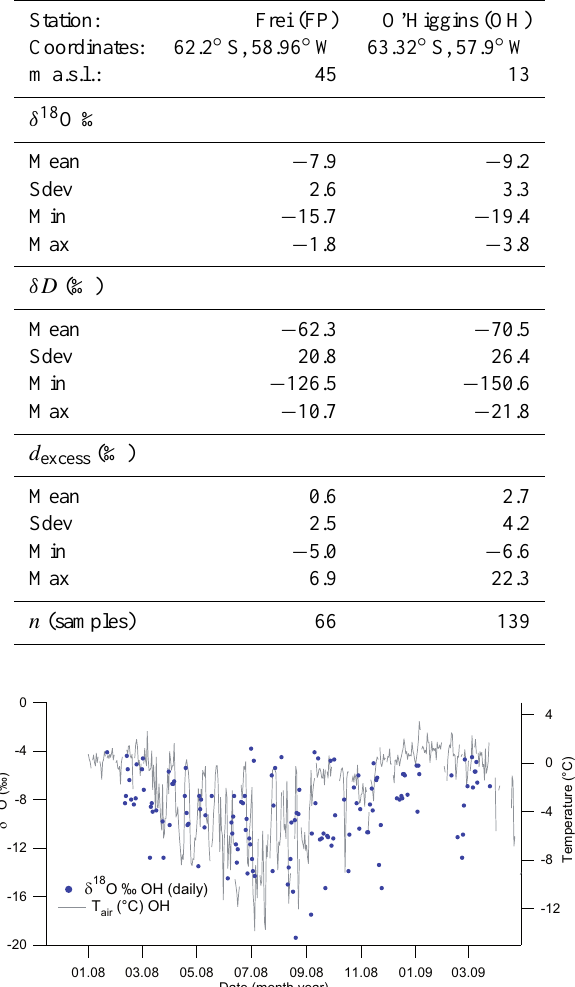
Table 2. Mean δ 18 O and δD values and basic statistics of precip- itation samples collected between February 2008 and March 2009, and geographical coordinates of the corresponding collection sta- tions: Frei (Fildes Peninsula, King George Island, South Shetland Islands) and O’Higgins (North Antarctic Peninsula).